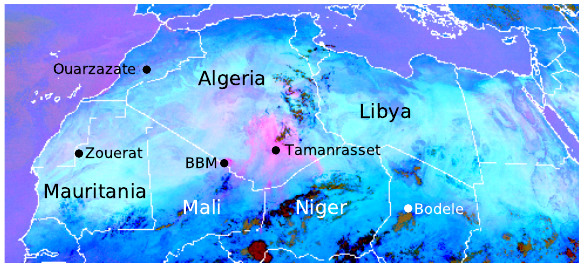
Figure 1. Dust RGB image from MSG-3 SEVIRI, 12:00UTC on 25 June 2013, including relevant countries and